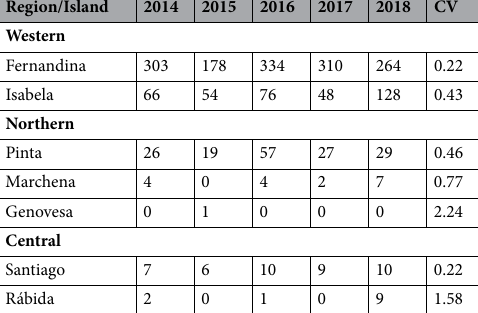
Table 3. Galapagos fur seal pups counted in breeding rookeries of the archipelago. The coefficient of variation (CV) shows the variability in the number of pups counted per island throughout the years.